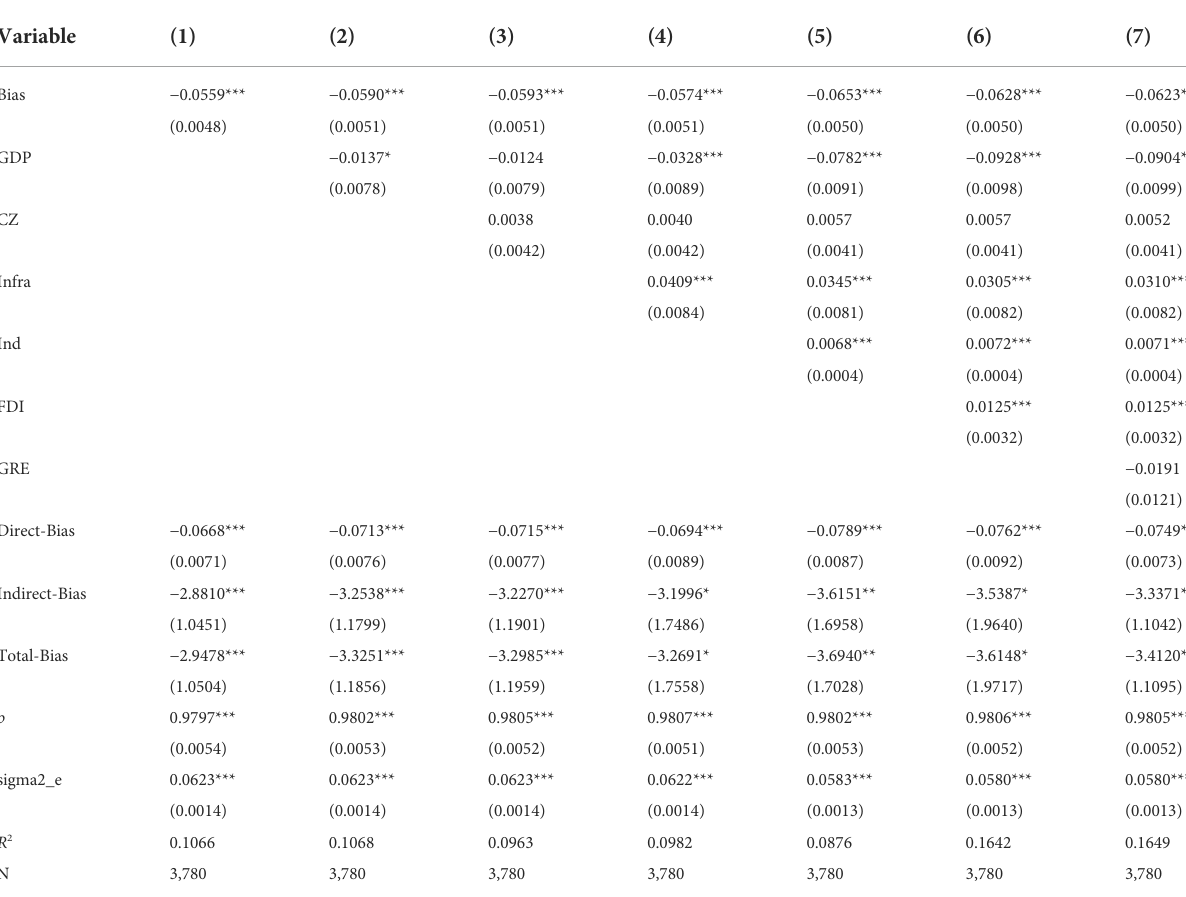
TABLE 4 Direct effects regression